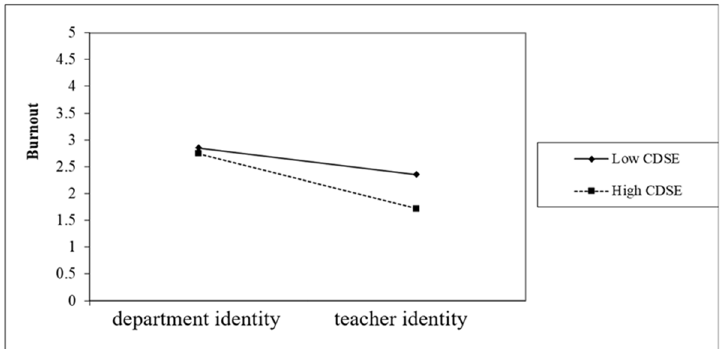
Figure 5. The moderation effect of profession identity on the relationship between CDSE and burn-